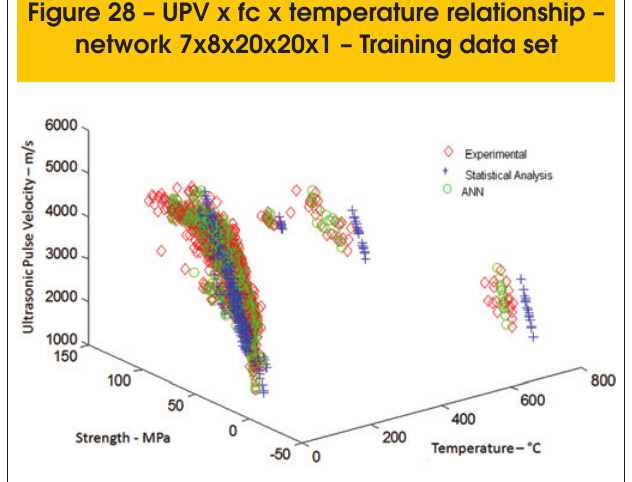
Figure 29 – UPV x fc x temperature relationship – network 7x8x20x20x1 – Test data